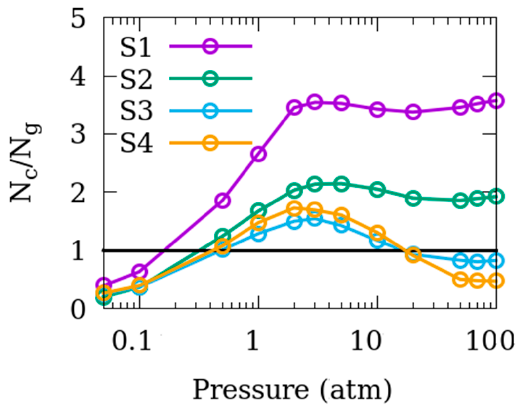
Figure 4. Ratio of the number of CO 2 molecules adsorbed in the Mg ‐ MOF ‐ 74 crystallites (N c ) to the number of molecules adsorbed in the inter ‐ crystalline space (N g ) for the systems S1–S4.